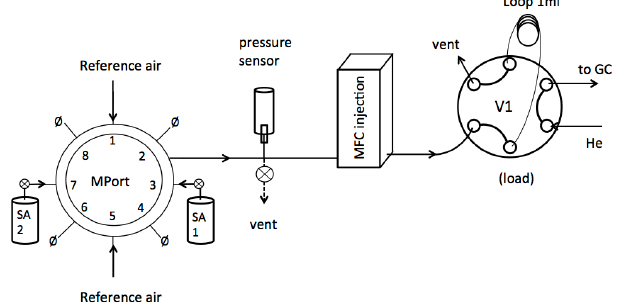
Figure 2. Schematic setup of the sample injection unit. From left: multiport valve (MPort), sample air canisters (SA1 and SA2), refer- ence air ports, pressure sensor, an automated vent valve, mass flow controller (MFC-injection) and Valco V1 with 1mL sample loop. All injection lines are 1 / 8 inch stainless steel tubes. Sample injec- tion is fully automated. Crossed circles above the air sample flask are